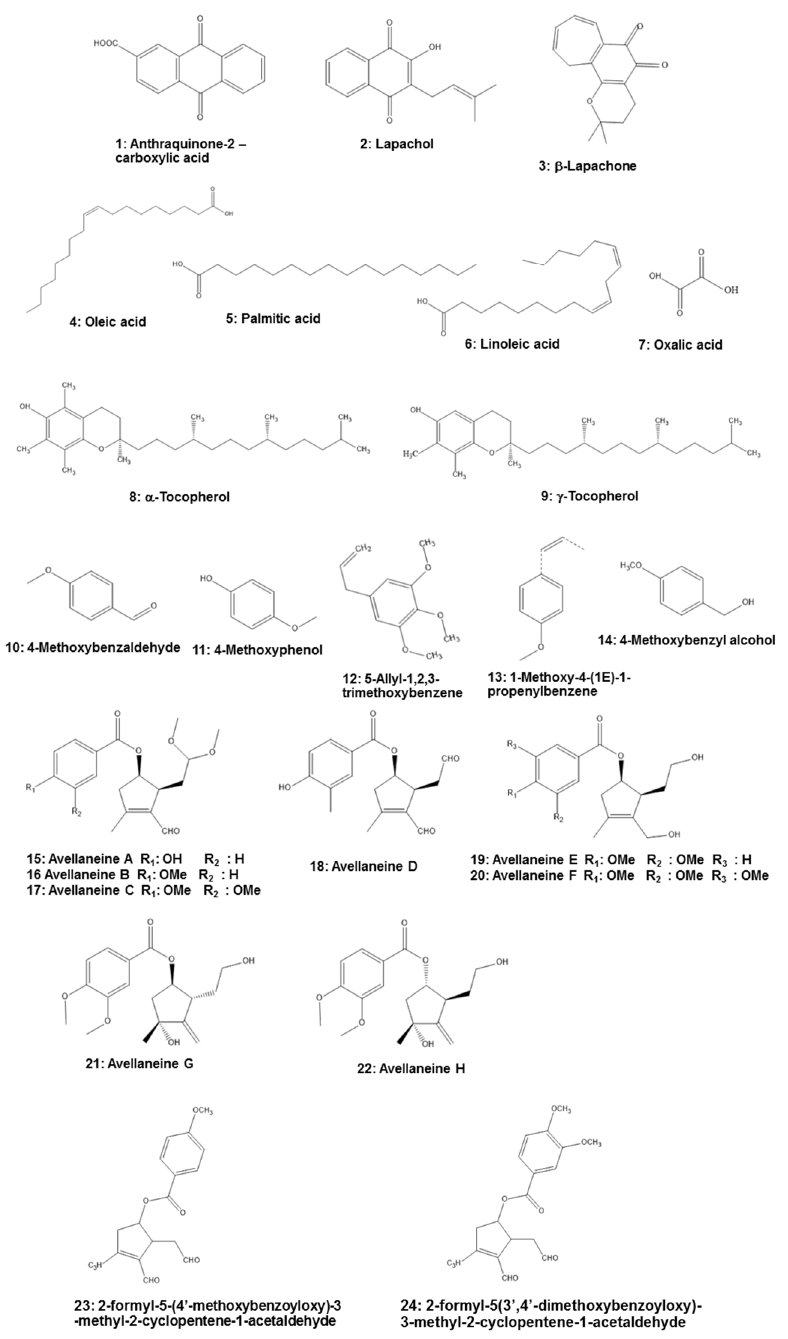
Figure 2. Chemical structures of Tabebuia impetiginosa -derived components.